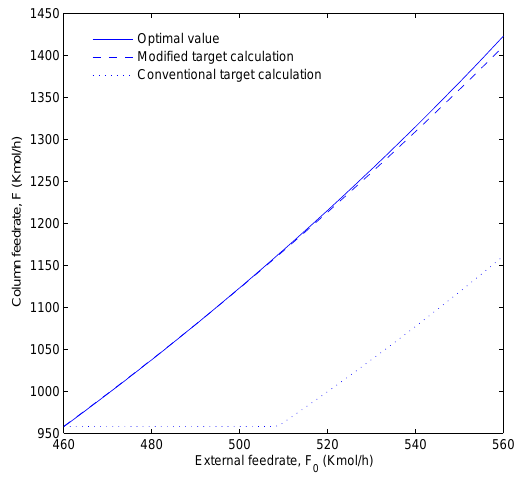
Figure 4: Column feedrate F , as function of external feedrate F 0